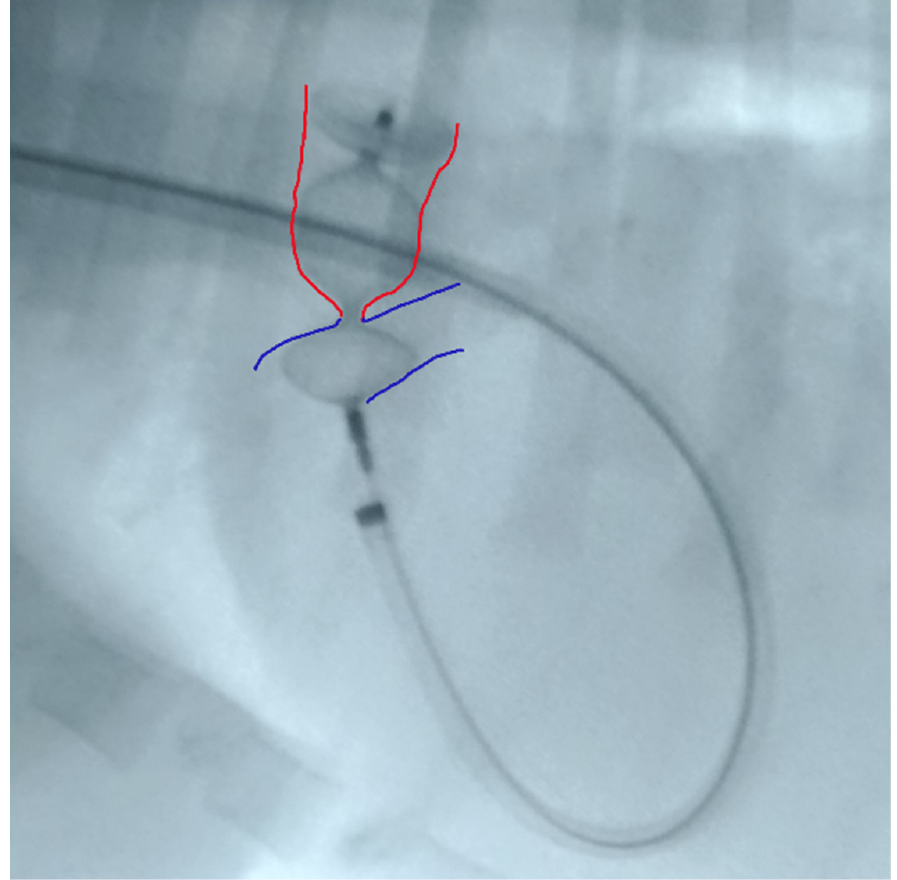
Figure 4. Device deployed in the main pulmonary artery with slight distension of the proximal disc. Red: ductal ampulla; Blue: pulmonary artery.